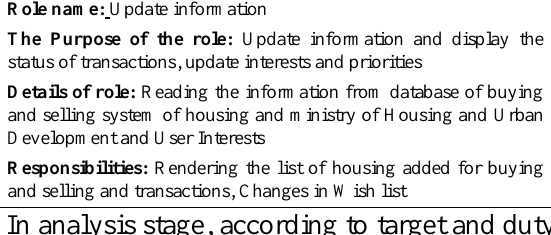
Table 11. Role model for the update information role.